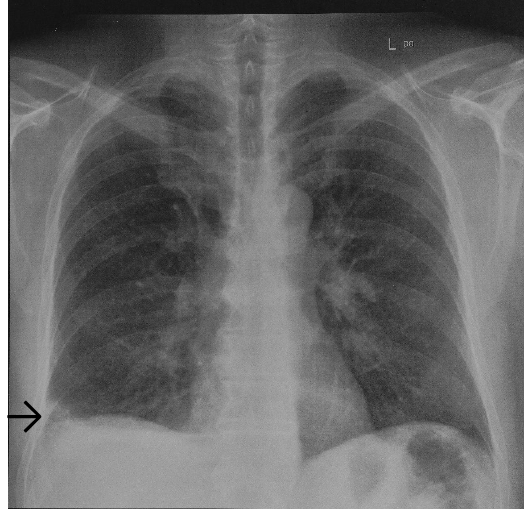
Figure 1. Posterior-anterior view of a chest radiograph demonstrating a basal wegde-shaped consolidation indicative for a Hampton´s hump (arrow) in the right lower lobe.